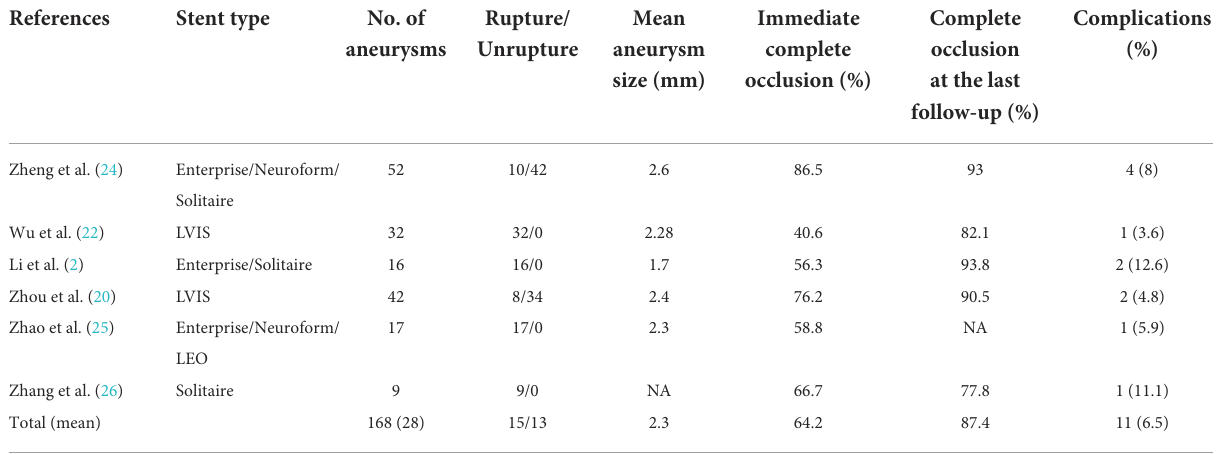
TABLE 4 Summary of studies examining stent-assisted coil embolization of tiny aneurysms ( ≤